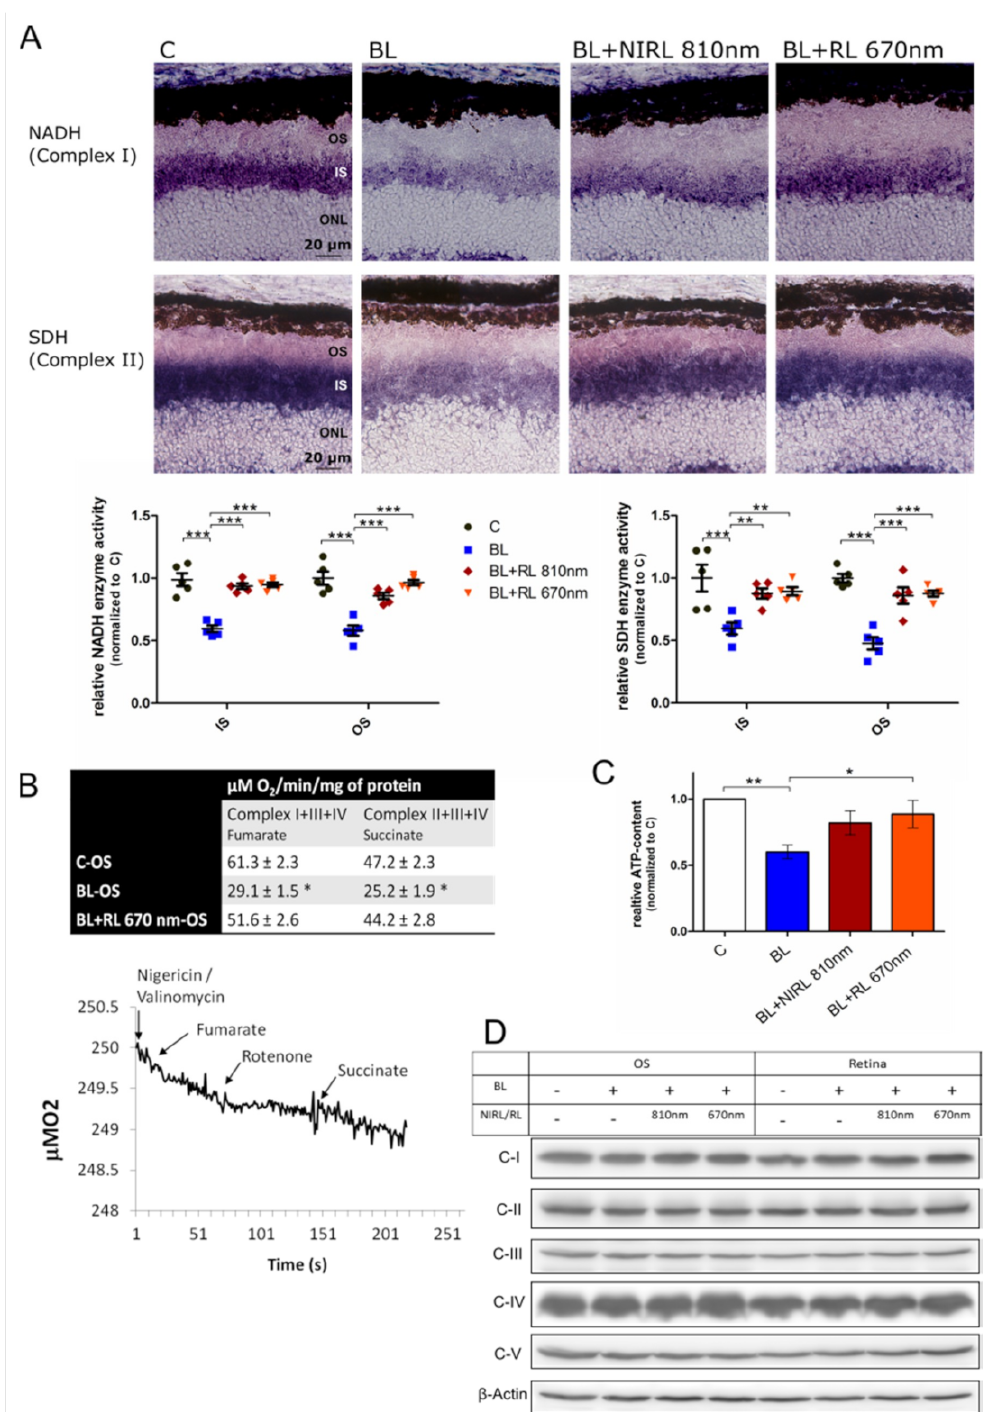
Figure 3. NIRL and RL increase oxidative phosphorylation in BL irradiated cells. ( A – D ) Late event analysis after 9 h of cultivation. Eyes were treated for 6 h with BL, following 10 min NIRL or RL and post-cultivated for another 3 h. ( A ) Representative images of NADH (Complex I) and SDH (Complex II) enzyme activity, labeled on unfixed retinal cryo-sections. Staining represents reduction of NBT to NBT-formazan catalyzed by oxidation of NADH or SDH. Retinal layers: outer segments [OS], inner segments [IS], outer nuclear layer [ONL]. The graph displays quantitative analysis of NADH and SDH relative enzyme activity: By measuring grey values of IS and OS the relative enzyme activity was calculated and normalized to Control (C). N = 5 experiments ± SEM. ( B ) Table shows oxygen consumption rates in purified OS (0.04 mg protein) for each of the two pathways: OXPHOS I + III + IV and OXPHOS II + III + IV. To stimulate the first pathway 20 mM fumarate was employed and 20